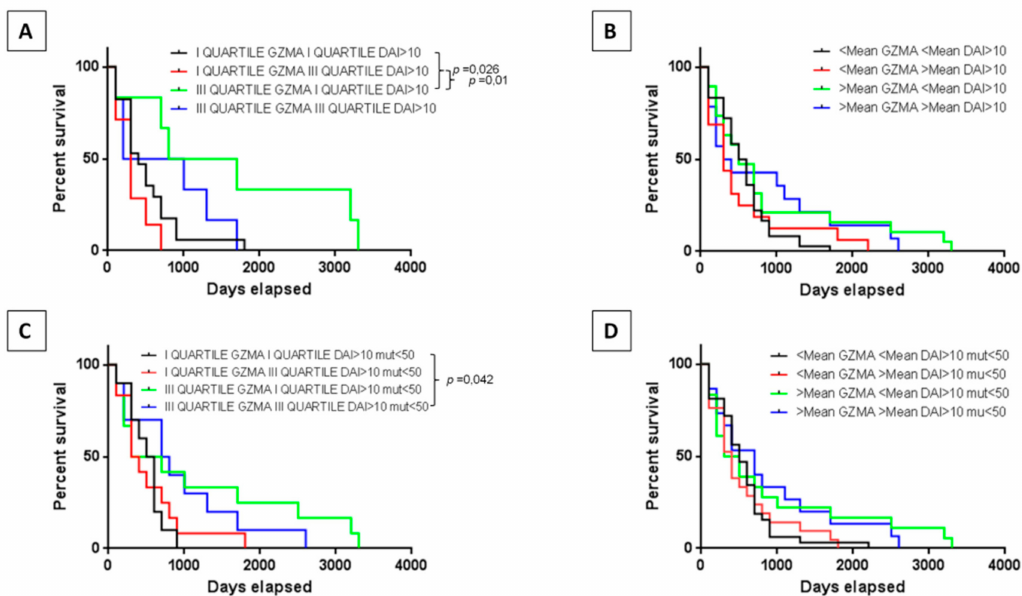
Figure 7. Neoantigens and survival. Survival of HCC patients correlating the GZMA gene expression with high and low number of neoantigens DAI > 10 or neoantigens DAI > 10 and a ffi nity < 50 nM in the validation set. The association was evaluated considering the value in the I and the III quartiles ( A , C ) as well as the value below and above the mean ( B , D